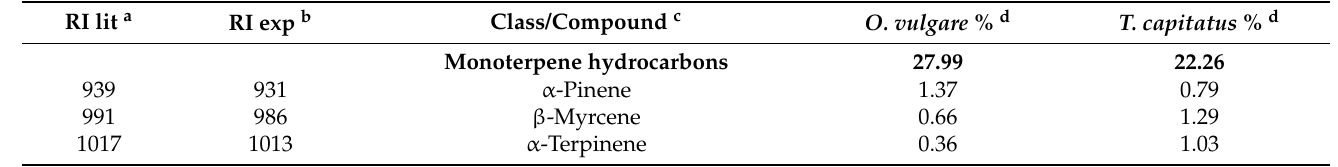
Table 6. Chemical composition of commercial Origanum vulgare and Thymus capitatus essential